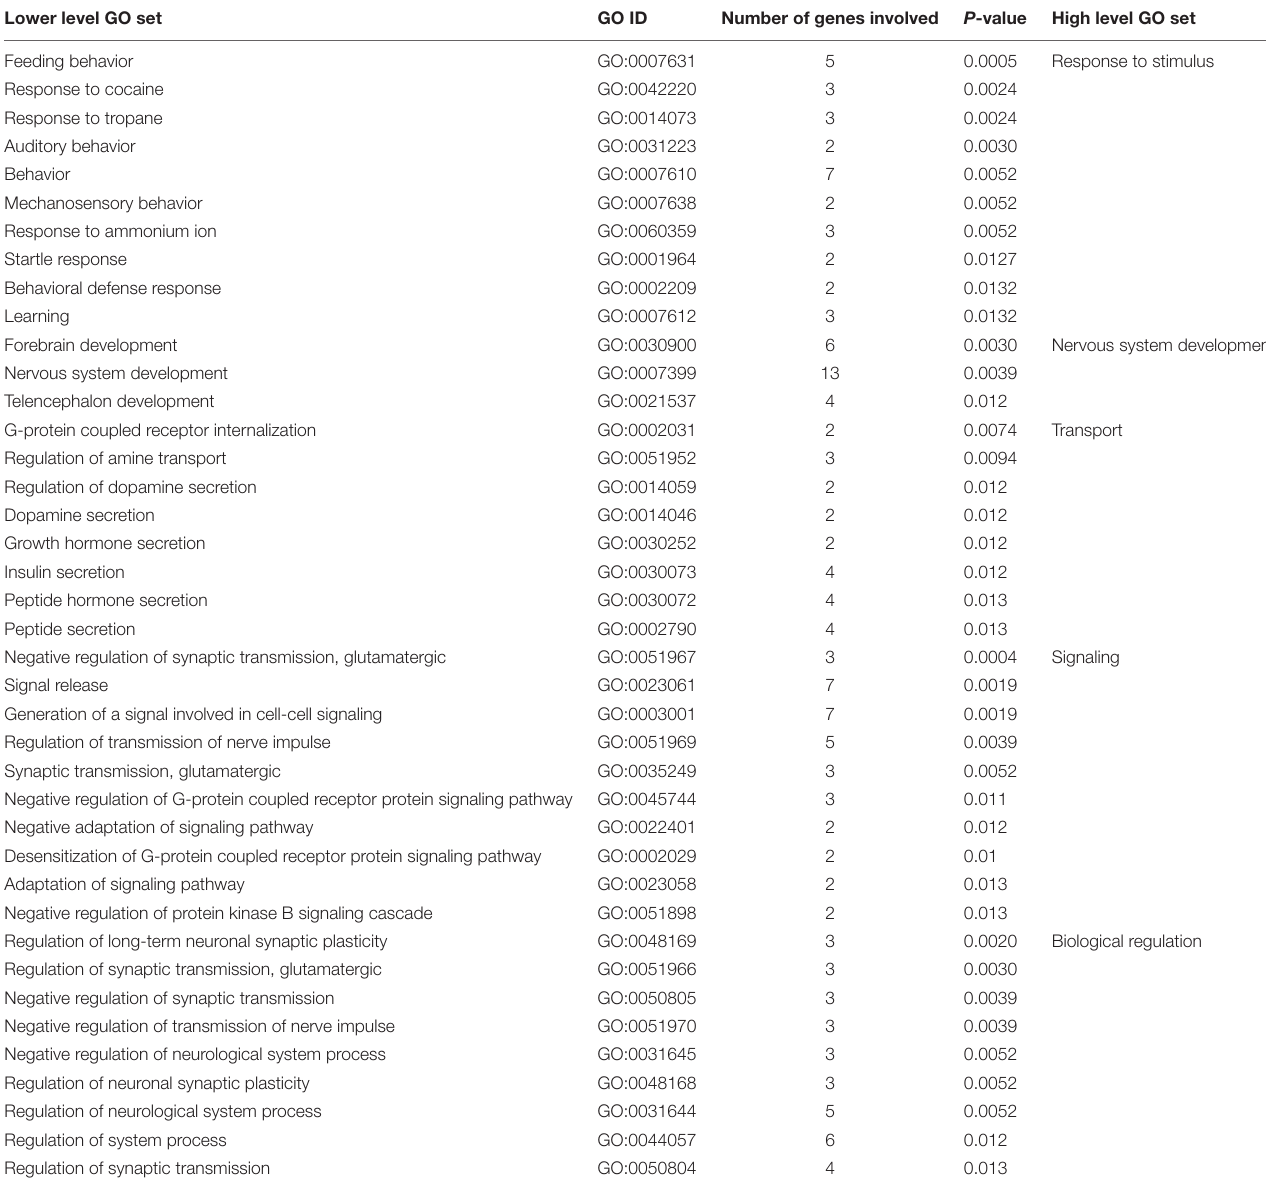
TABLE 4 | Lower level and high level GO sets enriched in genes associated with the ontogenesis of language lateralization. Lower level GO set GO